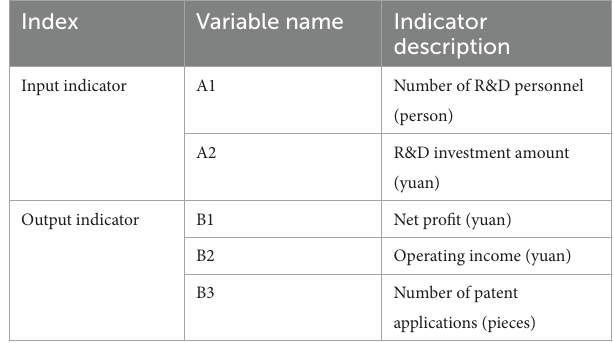
TABLE 1 Evaluation indicators of innovation efficiency of listed companies in the health